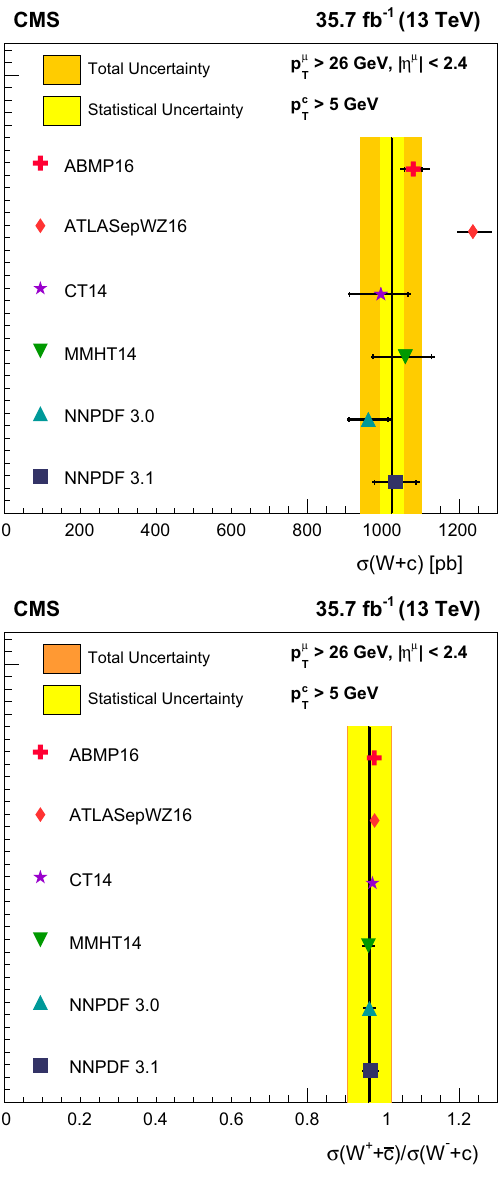
Fig. 4 Inclusive fiducial cross section σ( W + c ) and the cross section ratio σ( W + + c )/σ( W − + c ) at13TeV.Thedataarerepresentedbyaline with the statistical (total) uncertainty shown by a light (dark) shaded band. The measurements are compared to the NLO QCD prediction using several PDF sets, represented by symbols of different types. All used PDF sets are evaluated at NLO, except for ATLASepWZ16, which is obtained at NNLO. The error bars depict the total theoretical uncer- tainty, including the PDF and the scale variation